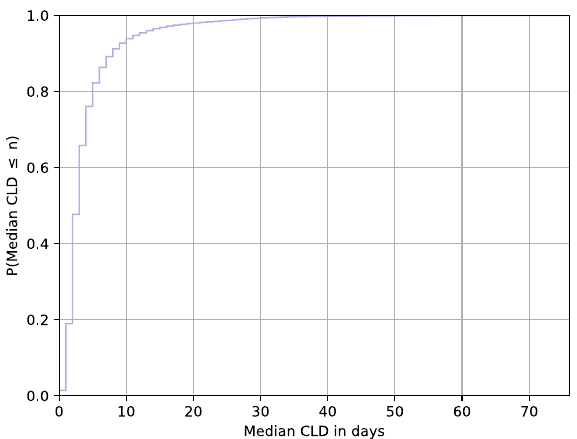
Fig. 10 Cumulative distribution of median CLD. Looking at the cumulative distribution of median CLD, we see that the curve fl attens out signi fi cantly around the ‘ elbow ’ at 9 days; thus, we choose greater than 9 days as our cutoff for our de fi nition of consistently highly